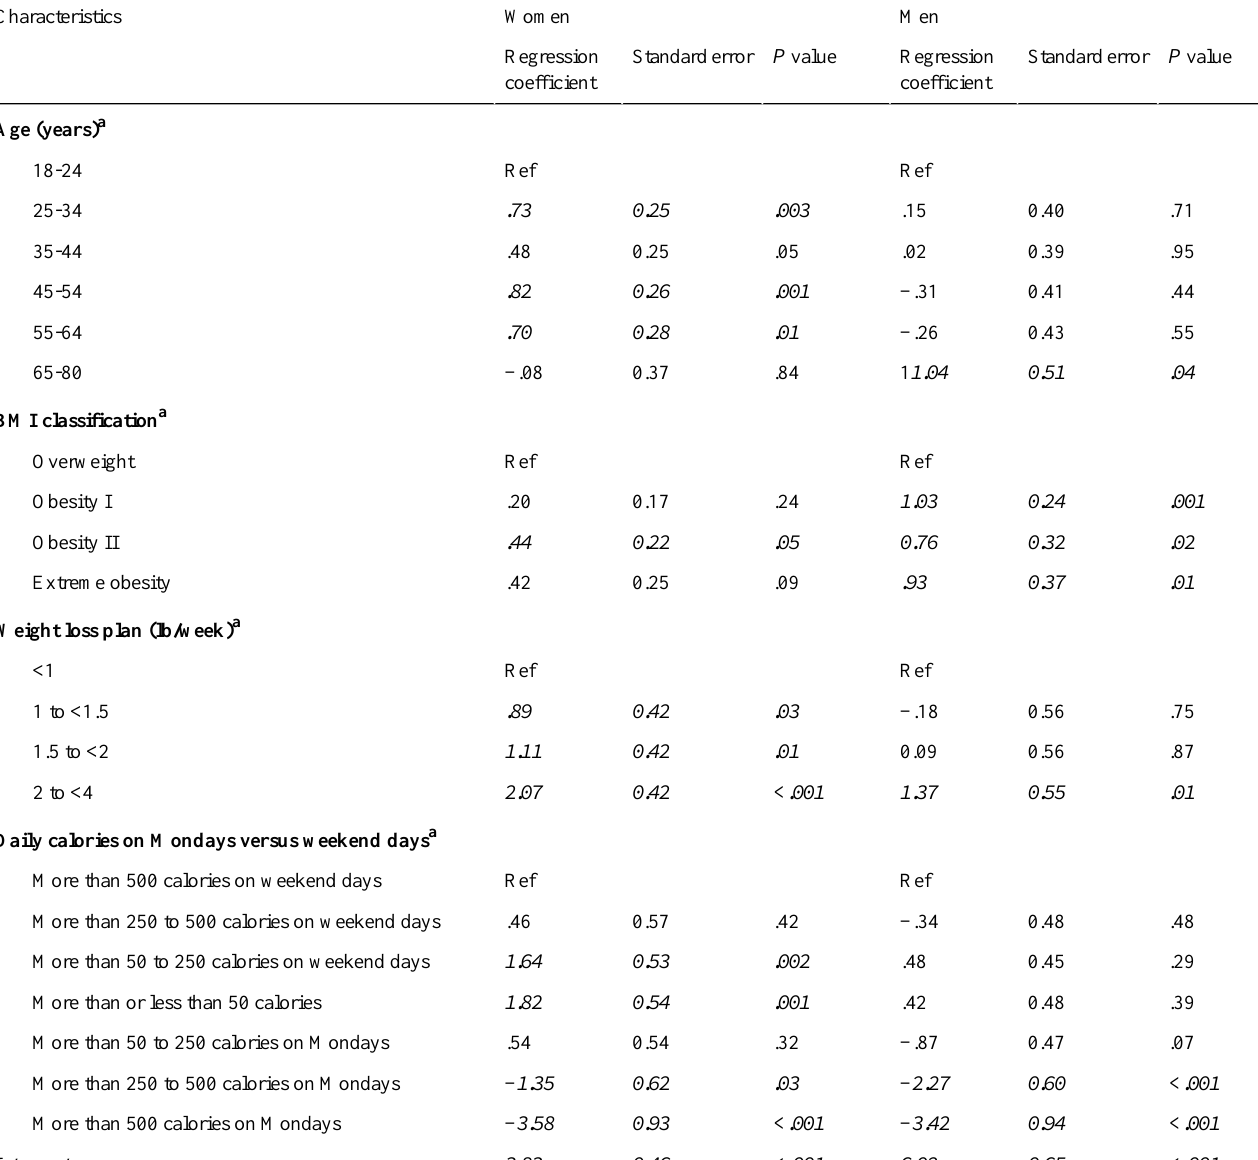
Table 3. Adjusted linear regression of percentage of bodyweight lost among women and men using the Lose It! mobile app (N=7007). Estimates in italics are significant at P <.05. BMI: body mass index. Ref: reference category.